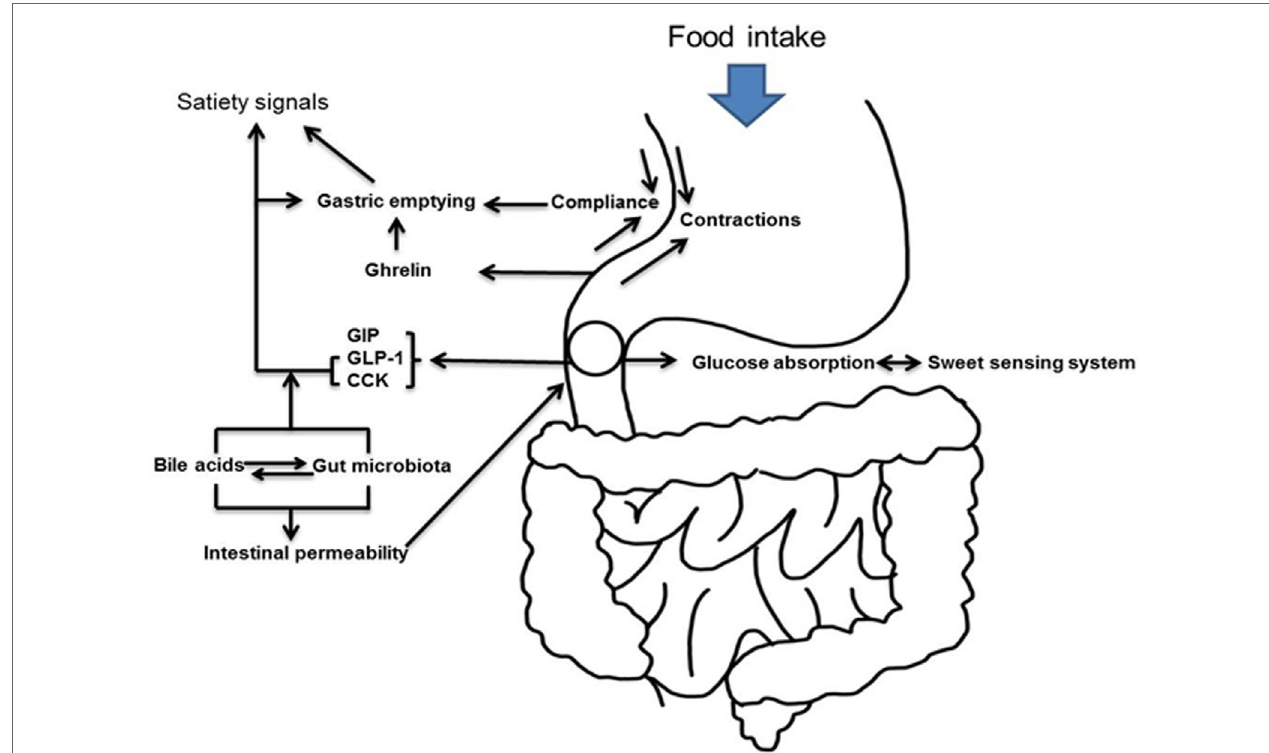
FiGURe 1 | Schematic representation of upper gastrointestinal tract and hyperglycemia.